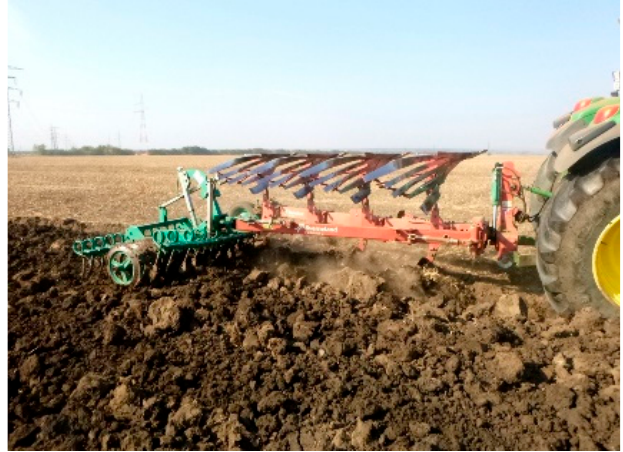
Figure 6. Ploughing at JTEF (Source: Igor Dekemati).